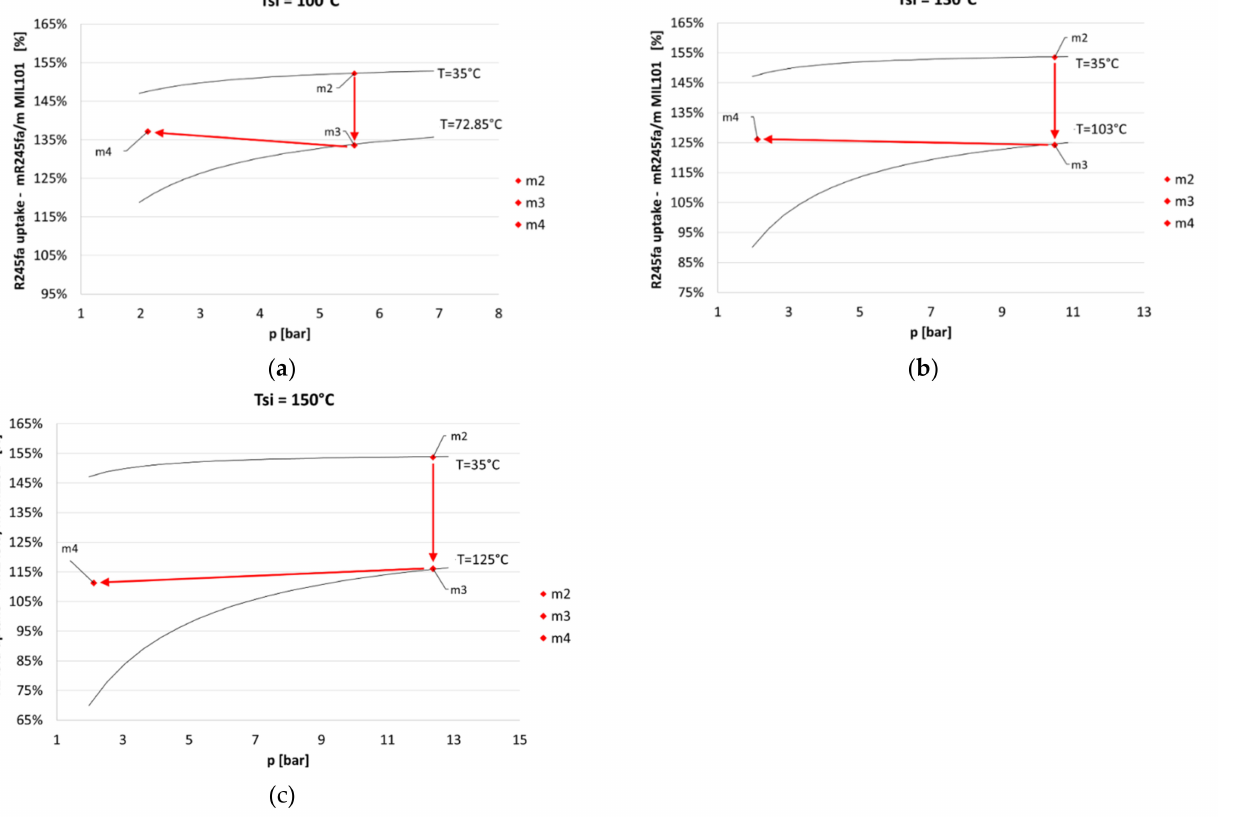
Figure 7. Uptake at the inlet of the HTHE (point 2) and at the expander inlet and outlet (points 3 and 4) for heat sources of 100 ◦ C ( a ), 130 ◦ C ( b ) and 150 ◦ C ( c